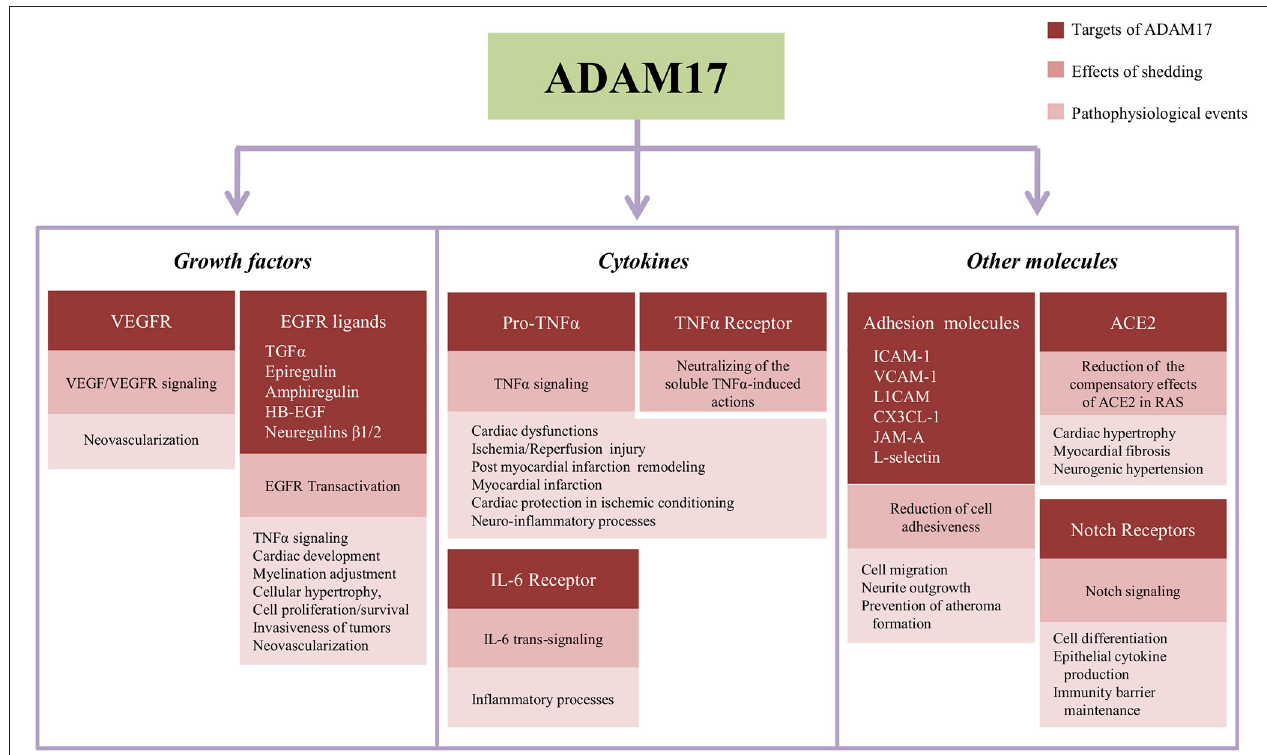
FIGURE 2 | Summary of targets of the shedding induced by ADAM17, subsequent effects in the cell signaling and events influenced by proteolytical cleavage in the cardiovascular and nervous systems. ACE2, angiotensin-converting enzyme type 2; CX3CL1, fractalkine; EGFR, epithelial growth factor receptor; HB-EGF, EGF-like growth factor; ICAM-1, intercellular adhesion molecule-1; IL-6, interleukin-6; JAM-A, junctional adhesion molecule-A; L1CAM, L1-cell adhesion molecule; RAS, Renin Angiotensin-System; TGF α , transforming growth factor α ; TNF α , tumor necrosis factor α ; VCAM-1, vascular cell adhesion molecule-1; VEGF, vascular endothelial growth factor; VEGFR, vascular endothelial growth factor receptor.